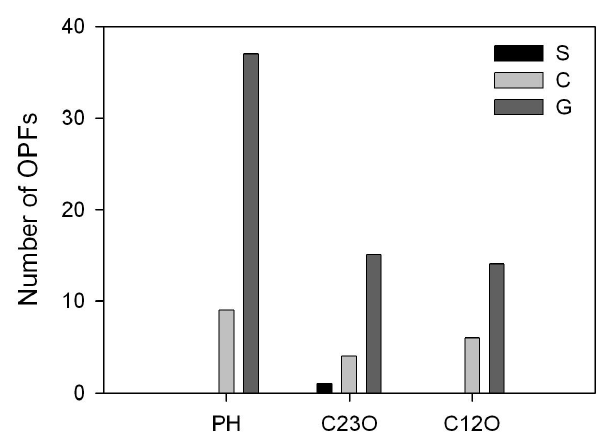
Figure 2. Number of the phenol hydroxylase (PH), catechol 2,3-dioxygenase (C23O) and catechol 1,2-dioxygenase (C12O) encoding the operational protein families (OPFs) detected in silico from the metagenomes of the surge pond (S), clarifier (C) and guard pond (G) samples.